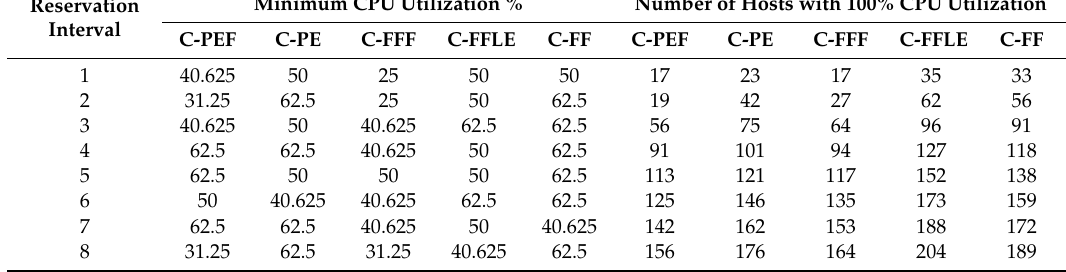
Table 6. Processor utilization for 100% RVA. Table 7. Power and carbon footprint for different VM placement algorithms. Table 7. Power and carbon footprint for different VM placement algorithms.